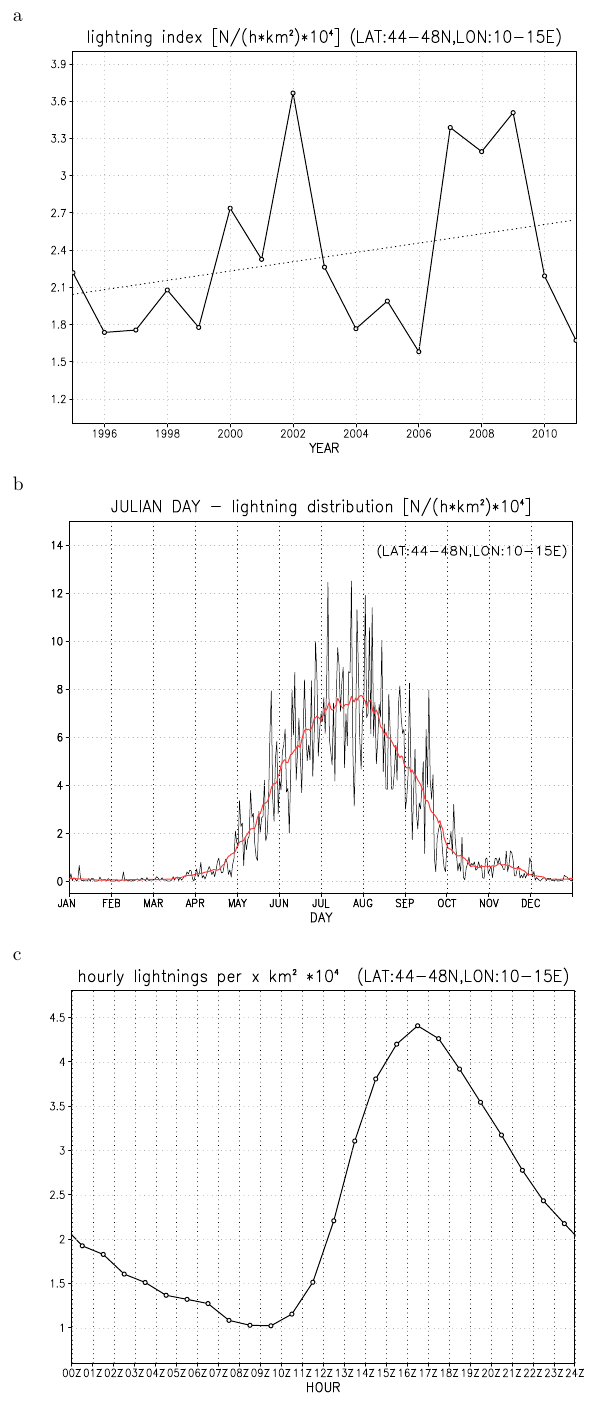
Figure 5. (a) Domain mean of C2G lightning annual distribution (solid) and the 17yr linear trend (dotted); (b) monthly distribution of C2G lightning with the ± 10 day moving average in red; (c) daily cycle of the C2G lightning distribution in the target domain. Units are number of flashes per hour per km 2 times a factor of 10 4